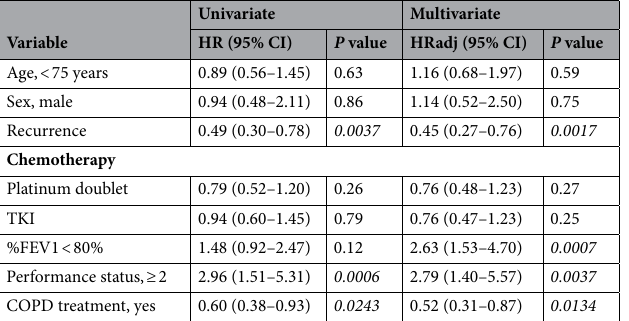
Table 4. Univariate and multivariate analyses of the association between various clinical characteristics and OS in the COPD group. Comparisons were made by means of chi-squared tests unless otherwise indicated. Significant values are in [italics]. TKI Tyrosine kinase inhibitors, FEV1 forced expiratory volume in 1